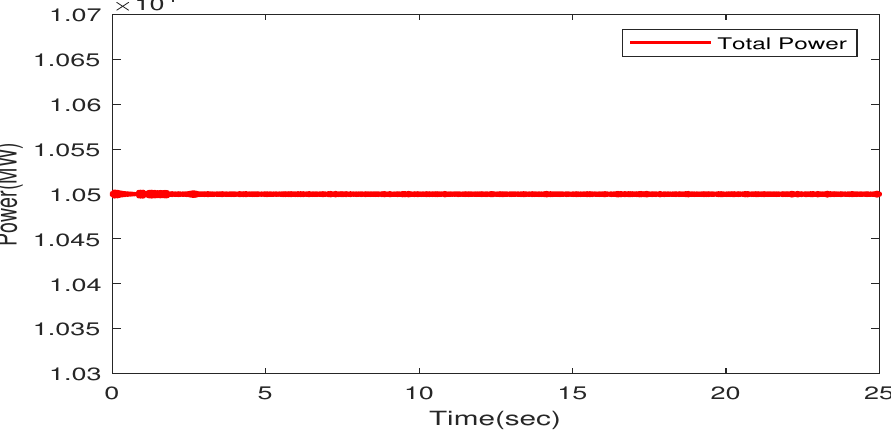
Figure 9. Total power generation in case of forty-unit